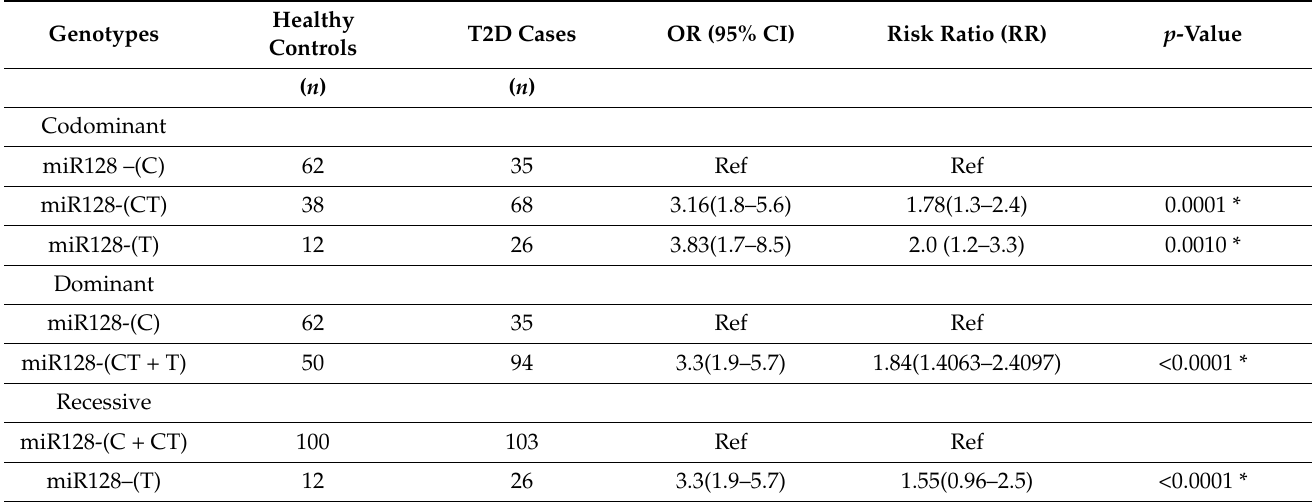
Table 12. Association of miR128 rs11888095 C/T with